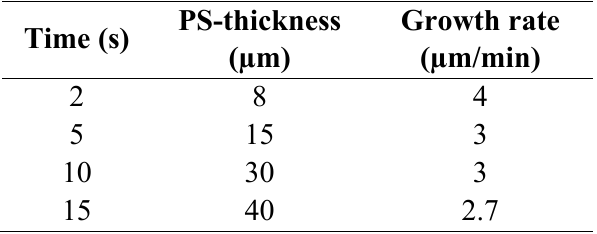
Table 1. Relation between anodization time and achieved thickness of the PS-layer. The growth rate drops with increasing etching-time.